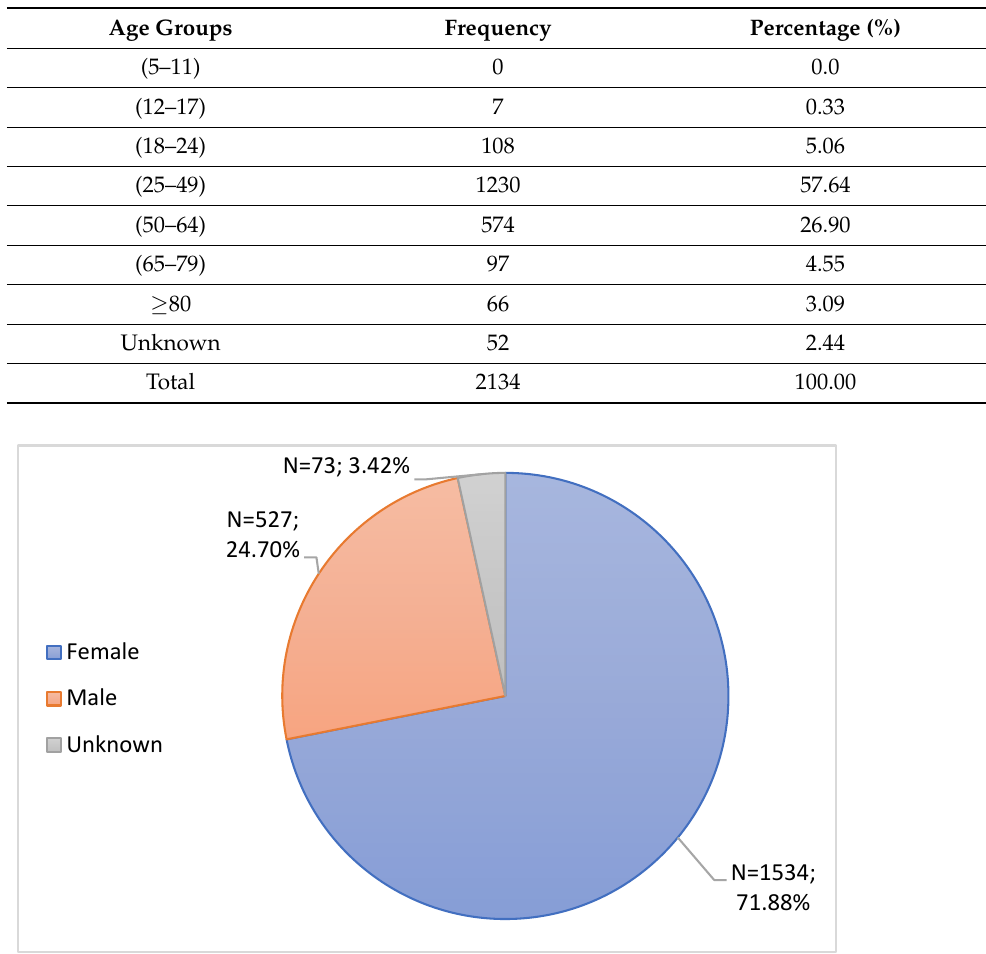
Figure 3. Characterization of notifications according to Gender.